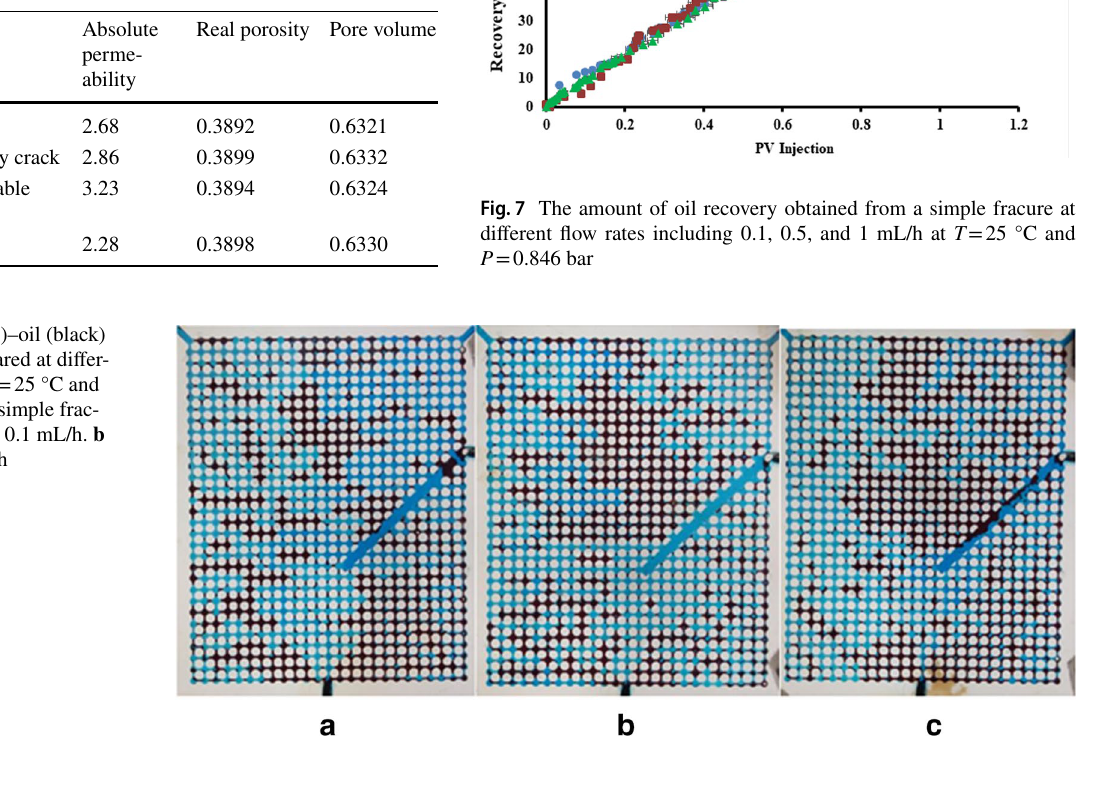
Table 2 Real porosity, absolute permeability, and pore volume of